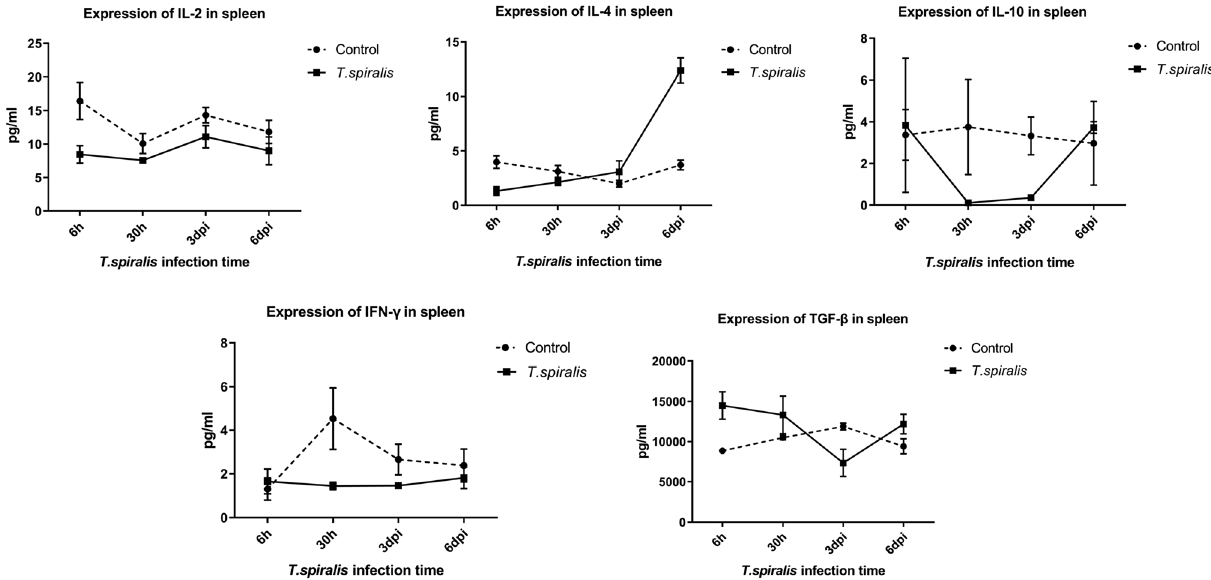
Figure 2. Cytokine expression levels of IL-2, IL-4, IL-10, IFN- c , and TGF- b in the spleen in mice infected with 250 muscle larvae of Trichinella spiralis.